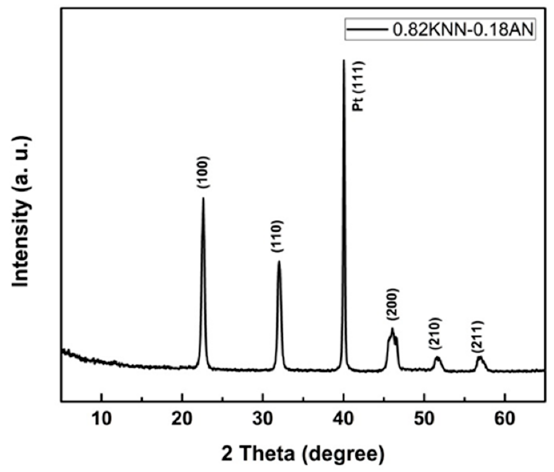
Figure 1. XRD pattern of the 0.82KNN-0.18AN film.